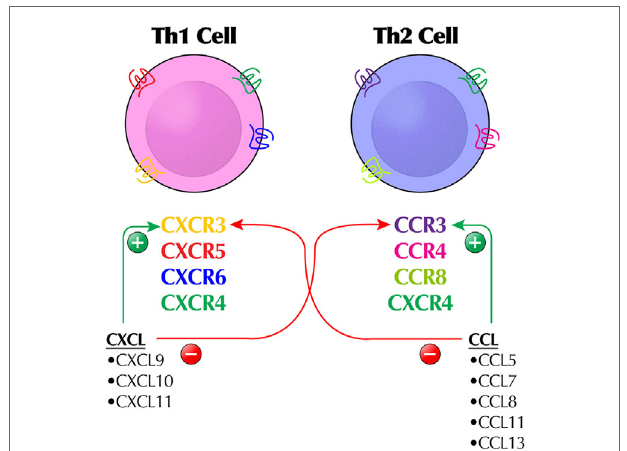
FiGURe 1 | The complex regulation of the chemokine (CK) system by a combination of agonist and antagonist activity illustrates why some CKs or chemokine receptors are not easy targets for immunomodulation and how different immunologic outcomes may occur. For example, CXCL9–11 are agonists at CXCR3 (expressing Th1 cells), but antagonists at CCR3 expressed by Th2 cells. Likewise, CCL5, CCL7, CCL8, CCL11, and CCL13 are agonists at CCR3-expressing Th2 cells. The typical stylized receptor depiction is meant to show the extracellular and intracellular domains of the receptor, which is a seven-transmembrane